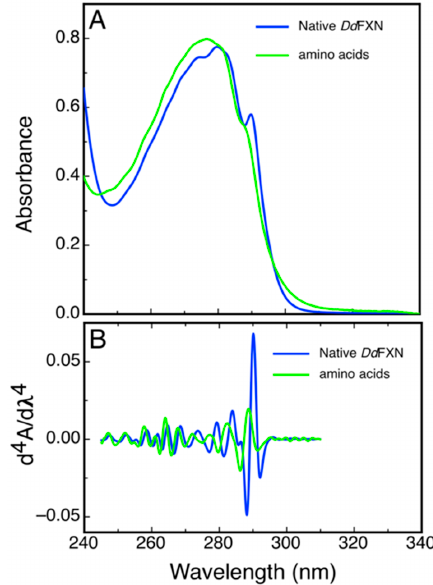
Figure 6. Characterization of DdFXN UV Absorption Spectra. UV absorption ( A ) and the fourth derivative spectra ( B ) corresponding to purified DdFXN (36.5- µ M protein concentration, blue) or a solution containing 109.5 µ M NATA, 109.5 µ M NAYA, and 182.5 µ M Phe (green). This composition of amino acid residues is the same (molar concentration of each residue) as in a 36.5- µ M DdFXN protein solution. The contribution to the absorption of the disulfide bonds was not taken into account because Cys residues were in the reduced state, as thiols. Int. J. Mol. Sci. 2020 , 21 , x FOR PEER REVIEW